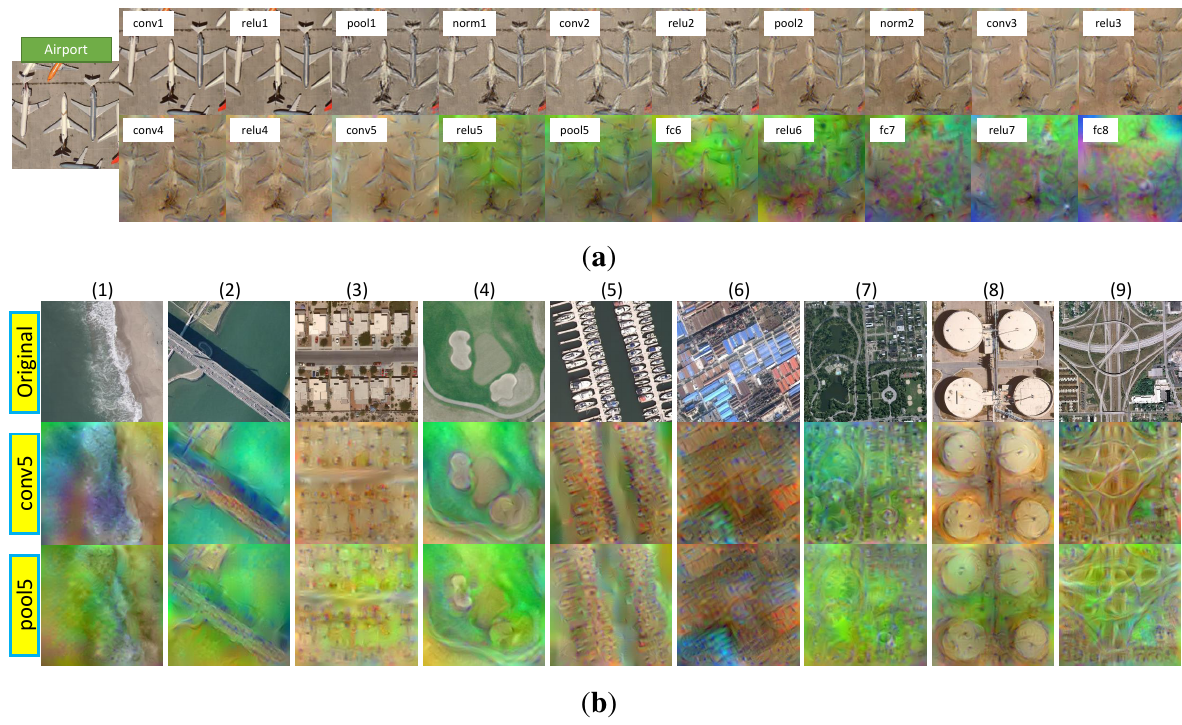
Figure 6. The time consumption of computing CNN activations with different CNN models for all image scenes in the UCM dataset. In this evaluation, the CNN activations from the first FC layer are extracted.